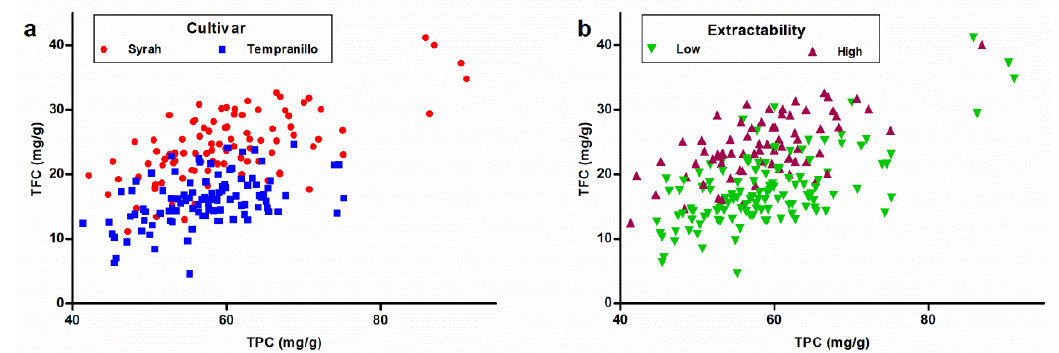
Figure 5. Representation of grape seed samples according their predicted total phenolic content (TPC) and total flavanolic content (TFC). Samples are codified as ( a ) Syrah or Tempranillo samples or ( b ) samples with low or high phenolic extractabilities.